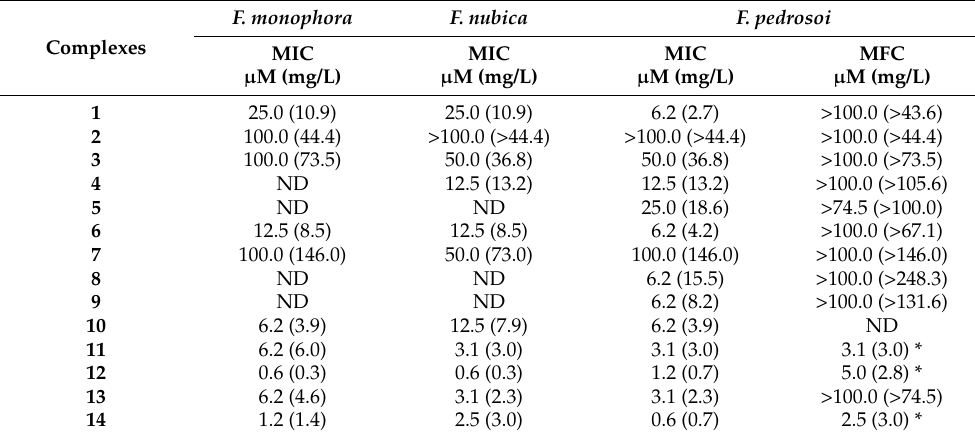
Table 2. Effect of metal complexes on planktonic growth of Fonsecaea